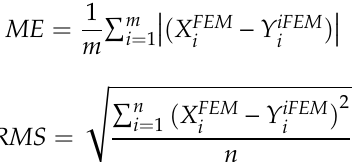
Figure 3. Deformation of the plate structure.